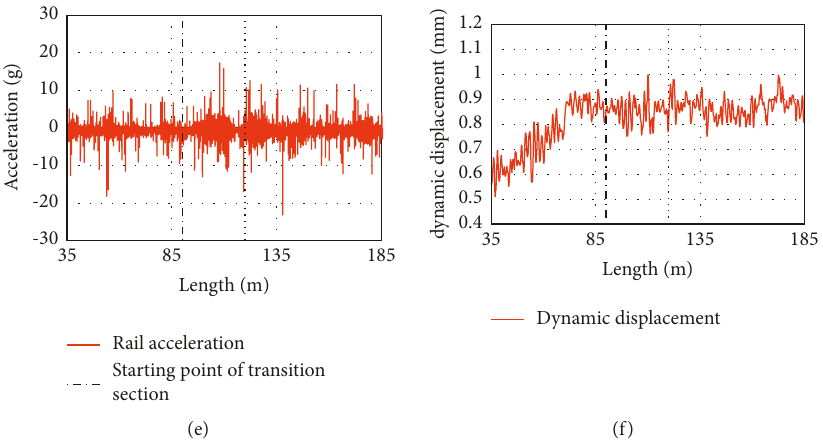
Figure 7: Dynamic response curve of vehicle-rail system under fastener stiffness transition. (a) Vertical acceleration of vehicle body. (b) Wheel-rail force. (c) Wheel load reduction rate. (d) Wheelset vertical acceleration. (e) Rail vertical acceleration. (f) Rail dynamic